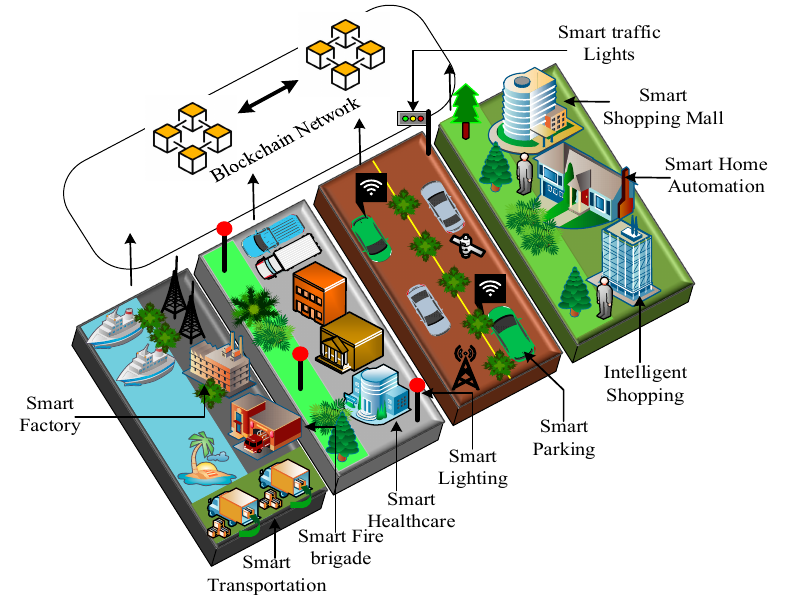
Figure 1. Smart city